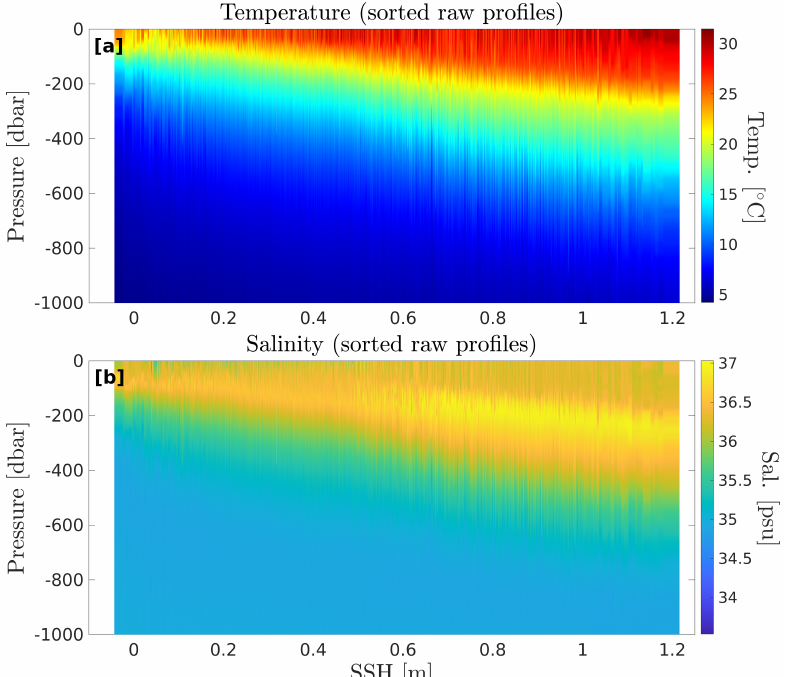
Figure 2. Steric height-sorted raw temperature ( a ) and salinity ( b ) profiles for the whole ARGO dataset. The x -axis represents 2000 dbar-referenced steric heigh ( η 2000 ) and the y -axis is pressure. The 2000 dbar-referenced steric height closely matches absolute dynamic topography (ADT), as shown in Figure